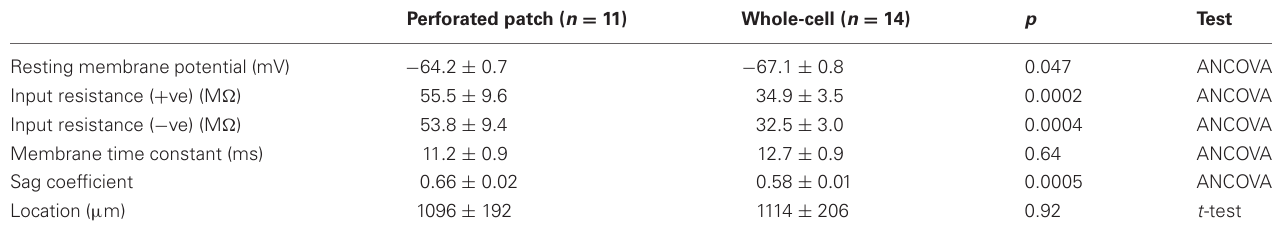
Table 1 | Sub-threshold membrane